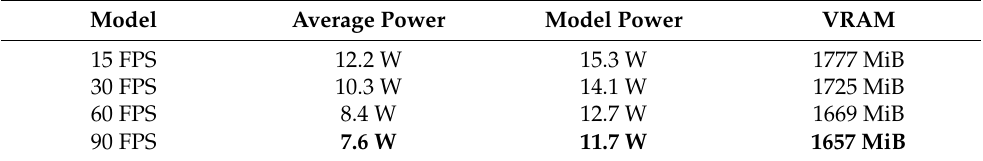
Table 13. Power consumption and required VRAM of the four models in 30 W power mode. Average power is the total power measured during inference including loading images. Model power is the power averaged over the raw model execution, i.e., the power needed for loading images is subtracted. The required power is significantly below the configured 30 W limit since not all of Jetson’s processing units are utilized. Moreover, the power draw decreases with a higher frame rate since the utilization of the high-power GPU decreases. The required VRAM decreases for the faster models since the smaller number of feature maps have a lower resolution and the smaller models have less parameters.